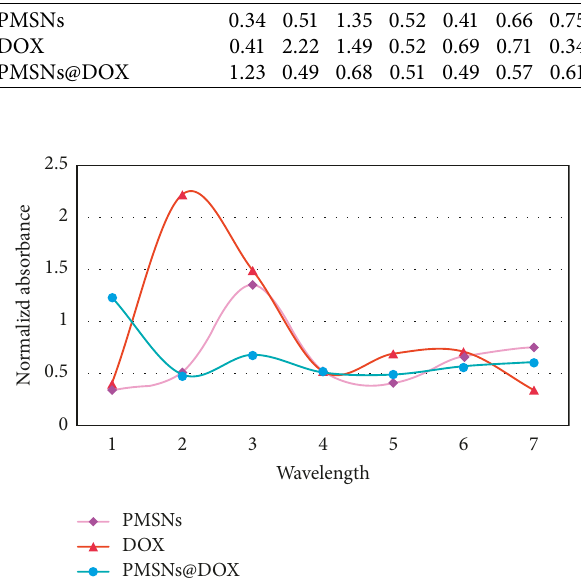
Figure 2: Ultraviolet visible light absorption spectrum.